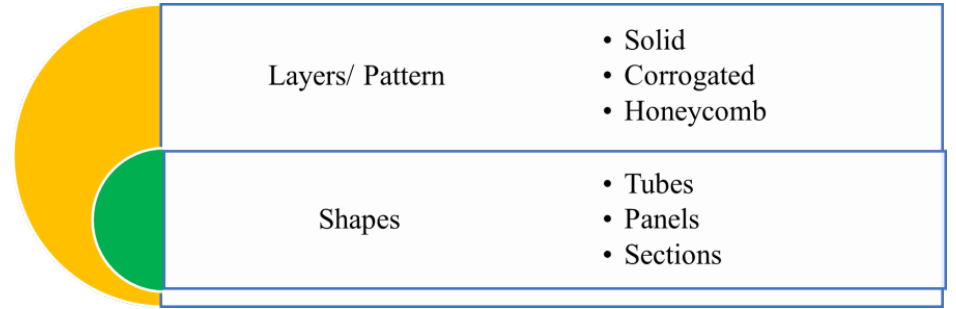
Figure 3. Cardboard classification based on use in construction. Based on the layers or pattern used in construction, cardboard can be classified as solid, corrugated, and honeycomb cardboard (Figure 4). Although solid cardboard is created from layers of sheets, corrugated cardboard can provide higher strengths and stiffness